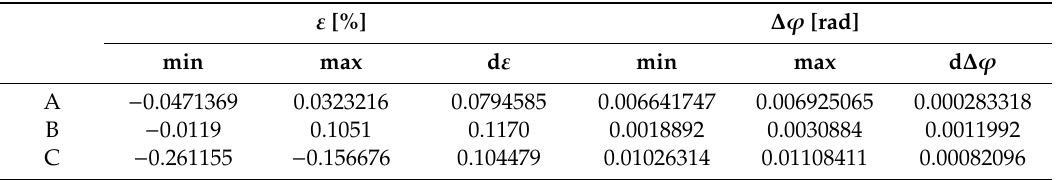
Table 3. Minimum, maximum, and variation of ε and ∆ ϕ during the 12-day test.